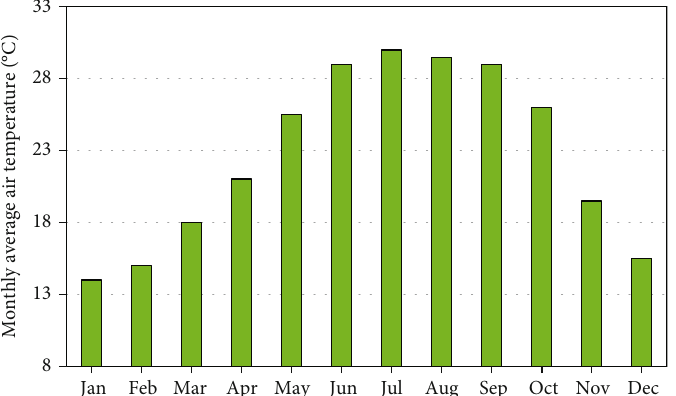
Figure 6: Monthly average air temperature.